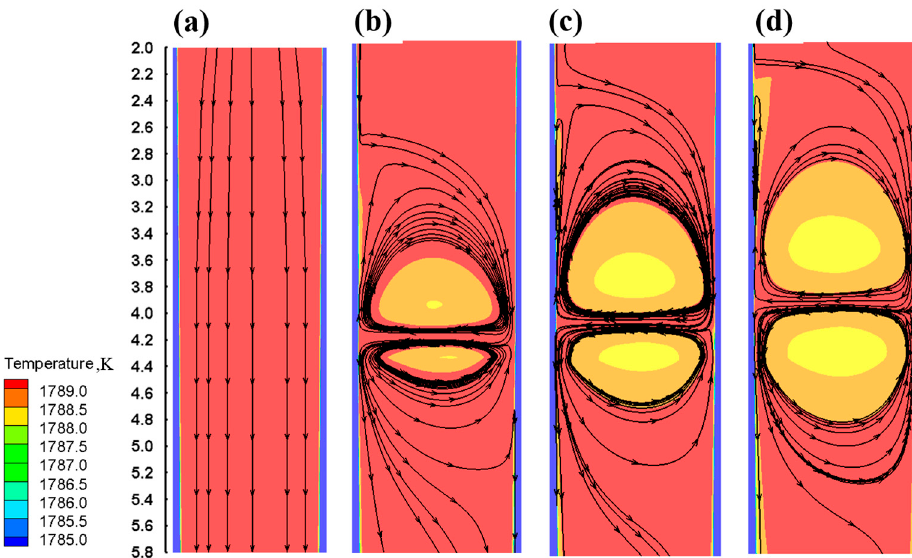
Figure 10. Temperature distribution and flow on the narrow center surface of the strand with ( a ) zero pairs, ( b ) one pair, ( c ) two pairs, and ( d ) three pairs of rollers.